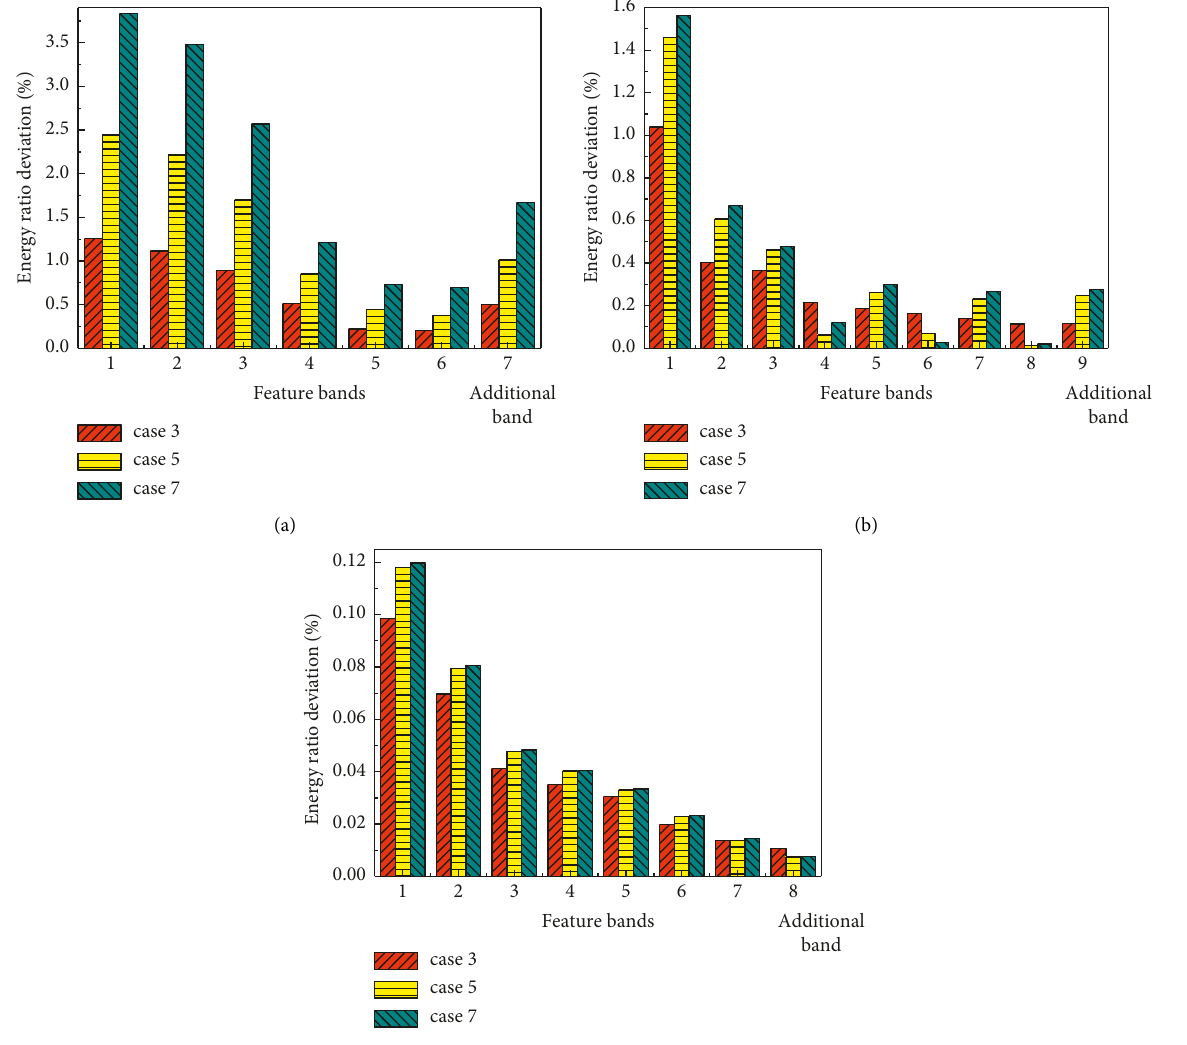
Figure 10: The Wavelet Packet damage feature vector of different measurement points (the second time test at excitation point II). (a) Point 4. (b) Point 5. (c) Point